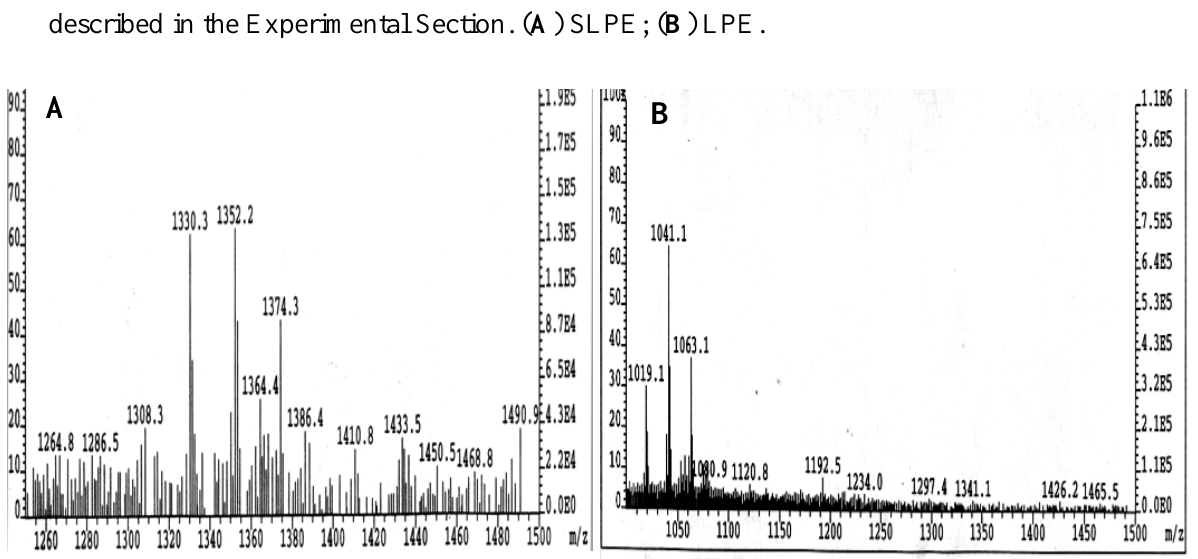
Figure 4. Characterization of SLPE and LPE by FAB mass spectrometry. Low resolution FAB mass spectrometry was performed on TLC/HPLC-purified SLPE and LPE as described in the Experimental Section. ( A ) SLPE; ( B )